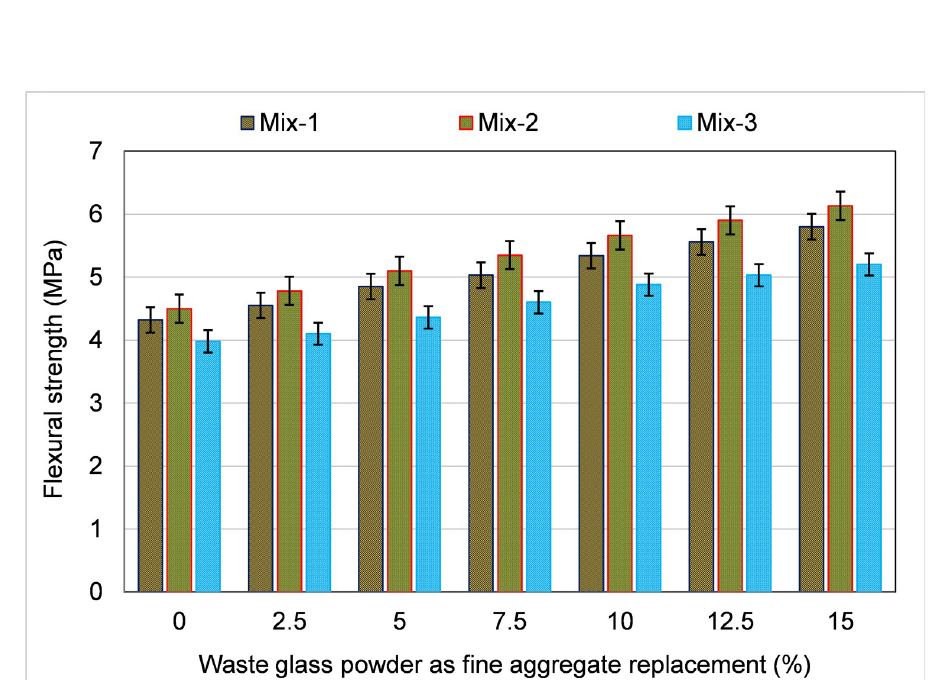
Fig 8. Influence of waste glass powder as a fine aggregate substitute on FS of specimens.